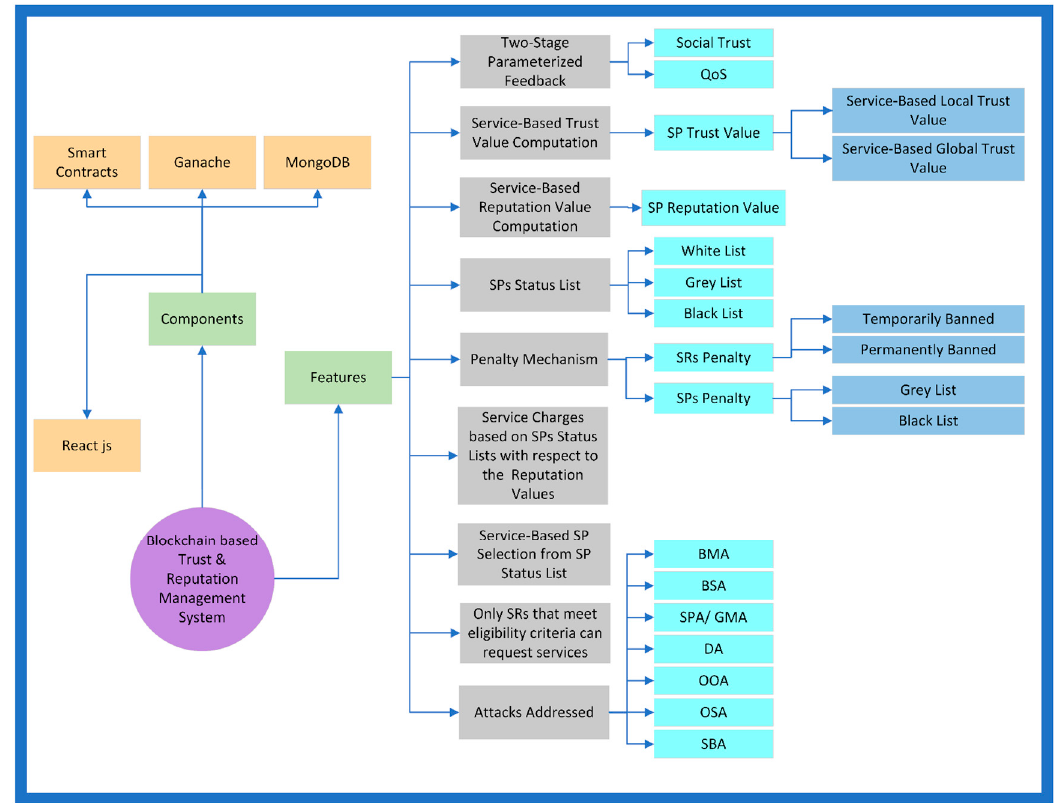
Figure 1. General representation of our Trust and Reputation Management Framework.